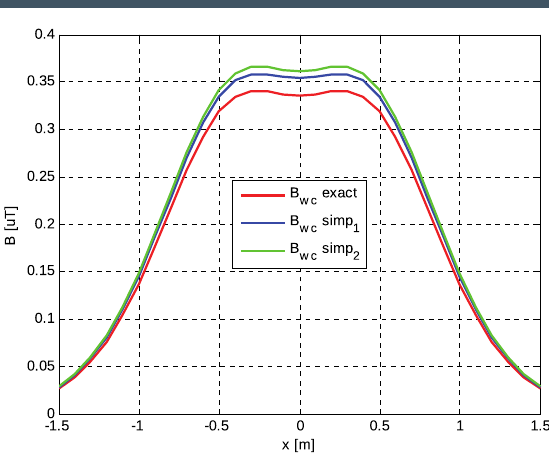
Table 4. B WC , B WC,simp 1 , B WC,simp 2 vs. distance x from the cable axis and relevant percent errors with respect to B WC for the first case